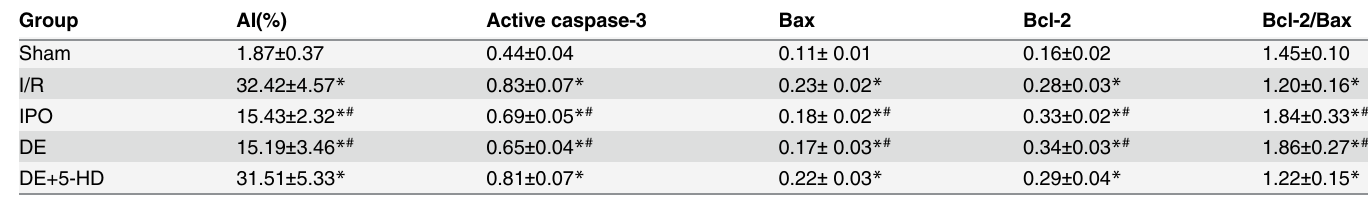
Table 1. The AI, expression of active caspase-3, Bax and Bcl-2, and comparison of the ratio between Bcl-2 and Bax in lung tissue (n = 10, x¯ ± s).